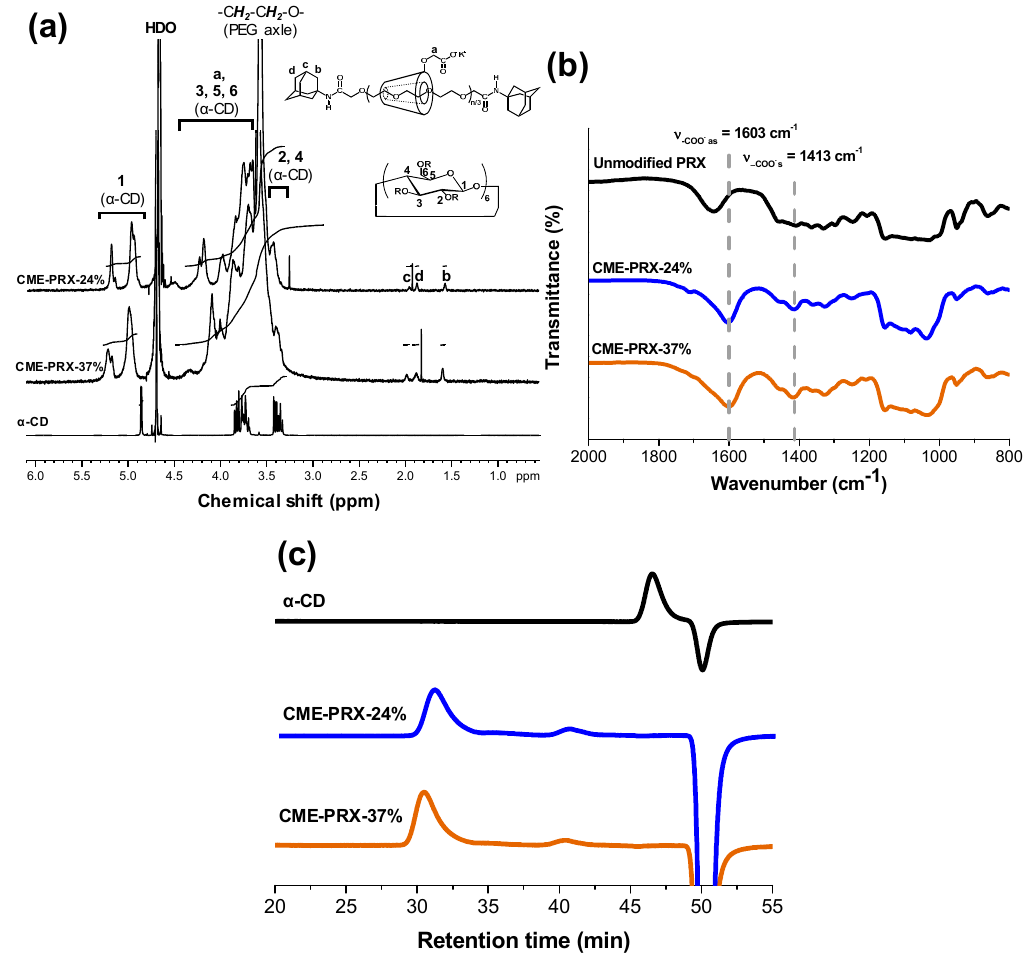
Figure 2. ( a ) 1 H NMR spectra of CME-PRX-24%, CME-PRX-37%, and α -CD in D 2 O; ( b ) FT-IR spectra of unmodified PRX, CME-PRX-24%, and CME-PRX-37%; ( c ) SEC charts of α -CD, CME-PRX-37%, and CME-PRX-24% in 100 mM NaNO 3 .